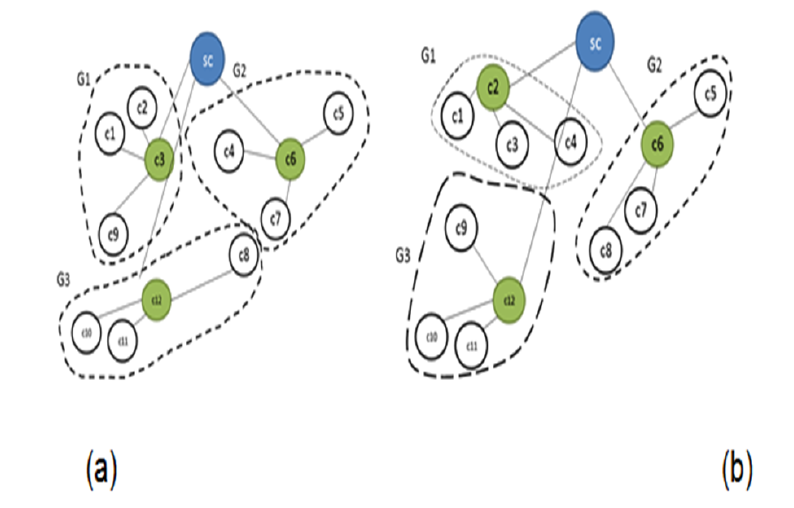
Figure 1. Three-tier control